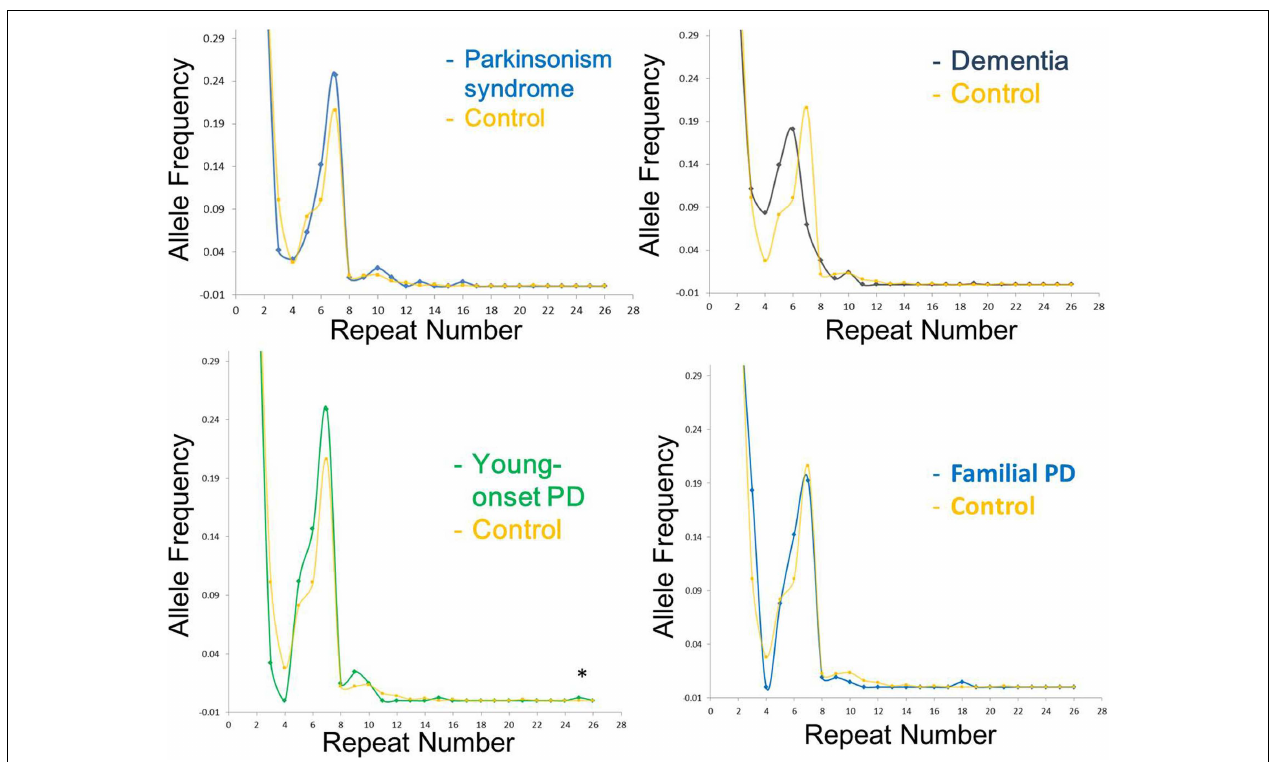
FIGURE 1 | Distribution of C9orf72 (C4G2) repeat number in different disease group as compared to control subjects in the current study .The X -axis represents the estimated repeat number, whereas the Y -axis represents the allele frequency. Asterisk indicates intermediate repeats (20–29 repeats).